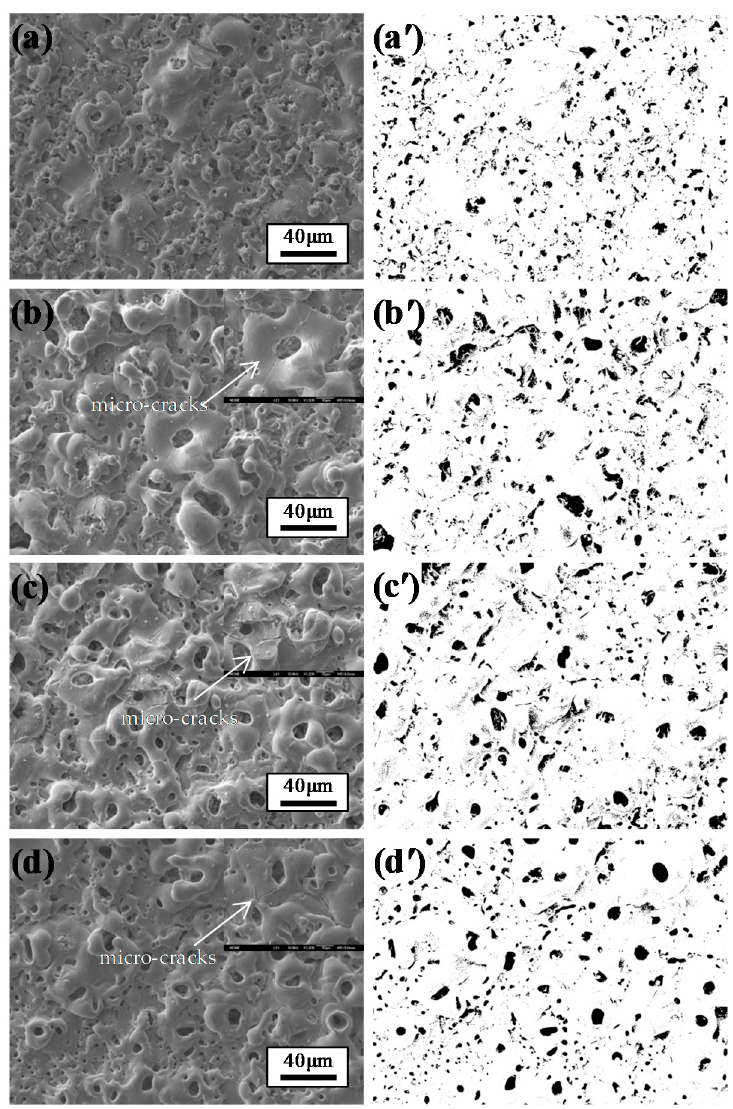
Figure 4. Surface morphologies and distribution of micro pores of MAO coatings under 480 V in di ff erent V 2 O 5 contents: 0 g / L( a , a’ ),0.2 g / L ( b , b’ ), 0.5 g / L( c , c’ ),and 0.8 g / L( d , d’ ).